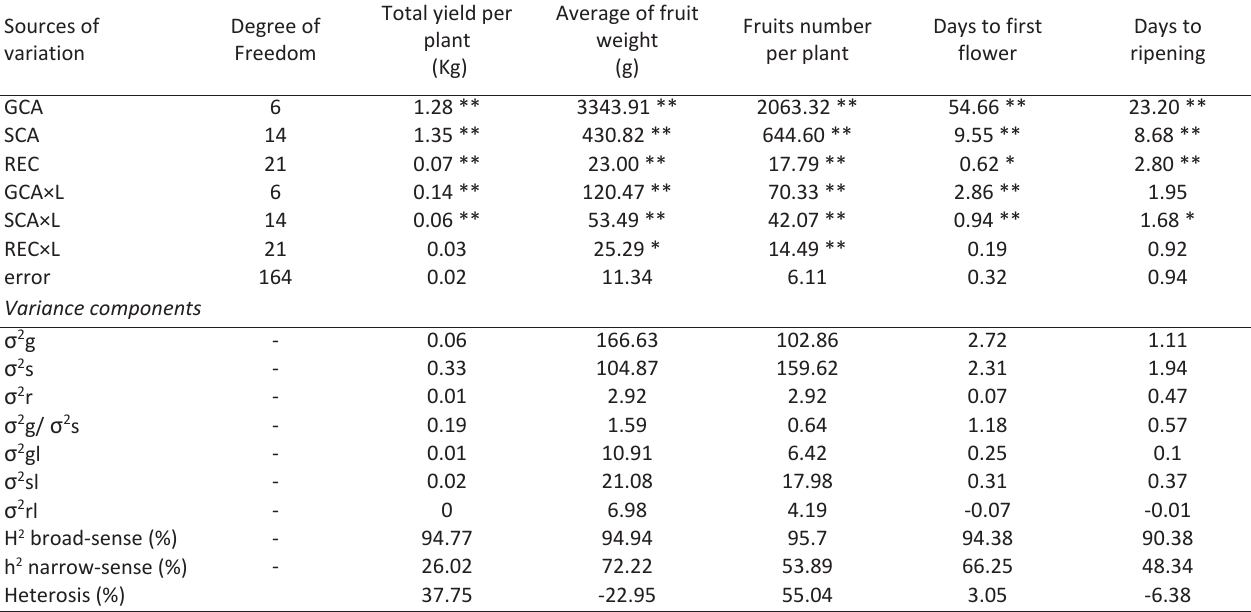
Table 4 - Compound analysis of variance for combining ability over two environments for yield, yield components and earliness of F1 hybrids with their reciprocals developed via a 7×7 full diallel cross and estimates of heritability in broad and narrow senses as well as